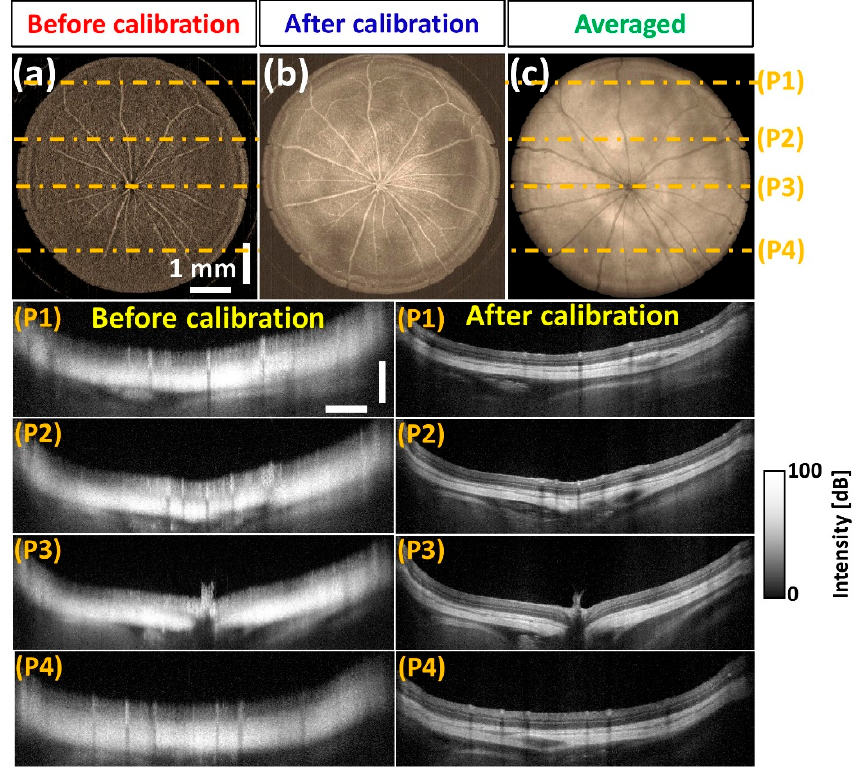
Figure 10. OCT image verification of in vivo rat posterior chamber along with B-scans corresponding to multiple positions. ( a ) Before calibration, ( b ) after calibration, ( c ) averaged posterior vitreous opacifications. The horizontal and vertical scale bars of P1–P4 (position 1–position 4) are 1 mm and 700 µ m, respectively.